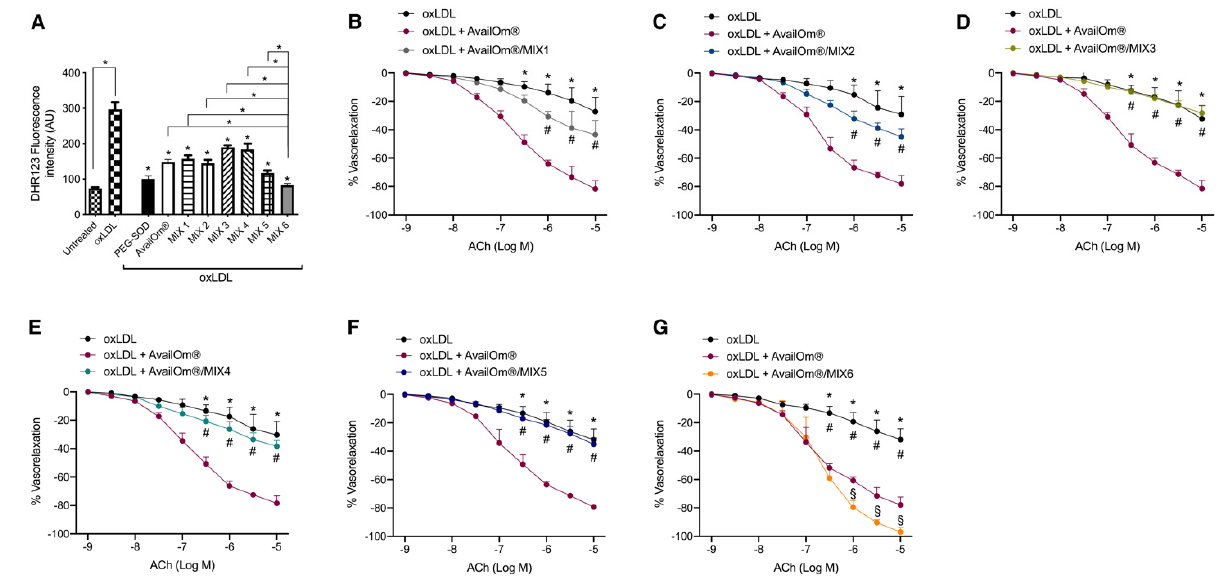
Figure 5. Vasculoprotective effects of the combination of AvailOm ® and different anthocyanins’ MIX against oxLDL-mediated ROS overproduction. ( A ) Measurement of ROS production by DHR123 in vessels treated with oxLDL alone or with PEG-SOD, AvailOm ® , or AvailOm ® plus MIX 1: C3-glu + C3-gal; MIX 2: Mal3-glu + Mal3-gal; MIX 3: C3-glu + DP3-glu + Mal3-glu; MIX 4: Mal3-gal + PEO3-gal; MIX 5: C3-glu + DP3-glu + C3-rut + Mal3-glu + Mal3-gal + PEO3-gal or MIX6: C3-glu + DP3-glu + Mal3-glu + Mal3-gal + PEO3-gal. Statistical analyses were performed using one-way ANOVA followed by Bonferroni post hoc test. * p < 0.05. ( B – G ) Vascular response of phenylephrine- precontracted mice mesenteric arteries to increasing doses of ACh (10 − 9 to M 10 − 5 M) after exposure to oxLDL for 30 min and then to AvailOm ® alone or AvailOm ® in combination with MIX1, MIX2, MIX3, MIX4, MIX5 or MIX6. * p < 0.05 vs. oxLDL + AvailOm ® . # p < 0.05 oxLDL + AvailOm ® ; § p < 0.05 vs. oxLDL + AvailOm ® .